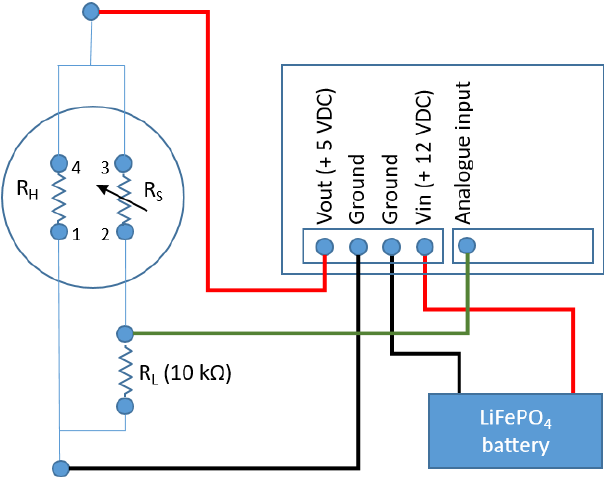
Figure 3. Simplified schematic of the metal oxide sensor (MOS) system consisting of a TGS2611-E00 with pin 3 and 4 connected to the 5V output of the Arduino Uno, pin 1 connected to ground, and pin 2 connected to the analogue input of the Arduino Uno and a 10k (cid:127) load resister, which also connects to ground.